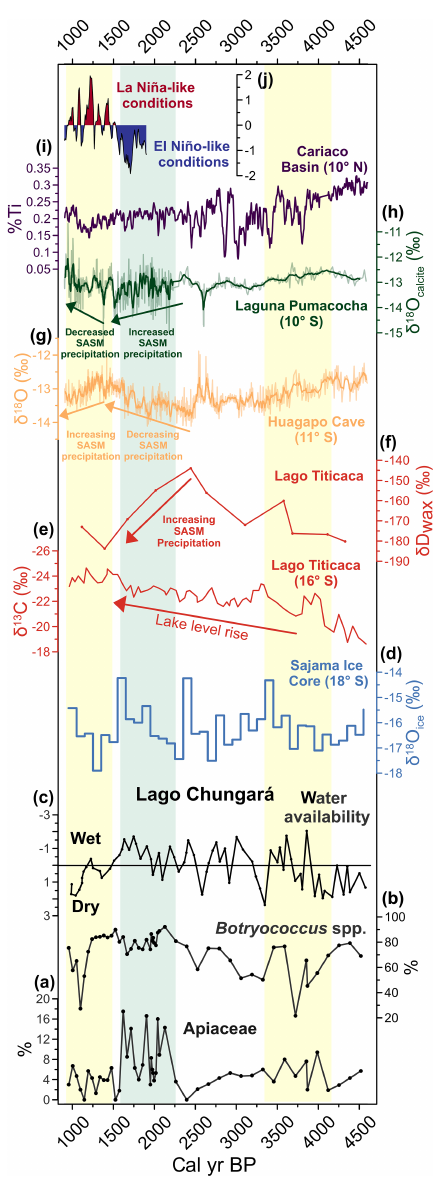
Figure 6. Summary plot including key Lago Chungará climate in- dicators (black curves) and selected paleoclimate records from the tropical Andes and the Pacific Ocean. (a) Apiaceae pollen percent- age, (b) Botryococcus spp. percentage, (c) Lago Chungará second eigenvectors (15%) of a principal component analysis from the geo- chemical dataset (Giralt et al., 2008), (d) δ 18 O record of ice wa- ter from the Sajama ice core (Thompson et al., 2000), (e) δ 13 C record from Lago Titicaca (Baker et al., 2005), (f) δ D record of terrestrial leaf waxes from Lago Titicaca (Fornace et al., 2014), (g) δ 18 O record from speleothems inside Huagapo Cave (Kanner et al., 2013), (h) δ 18 O record of calcite in sediments from Laguna Pumacocha (Bird et al., 2011), (i) %Ti from Cariaco Basin (Haug et al., 2001), and (j) Southern Oscillation Index (SOI) reconstruction from eastern and western tropical pacific records (Yan et al., 2011). Yellow bands indicate dry anomalies, whereas the green band shows the wet anomaly as recorded in Lago